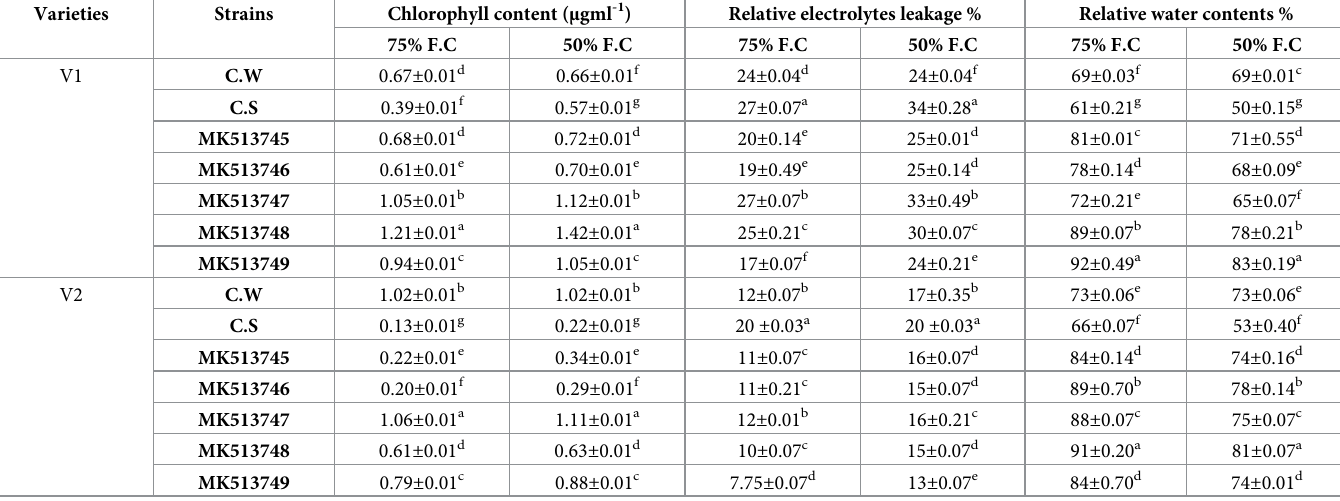
Table 3. Effect of PGPR on physiological parameters of V igna radiata under different stress levels in pot trials.